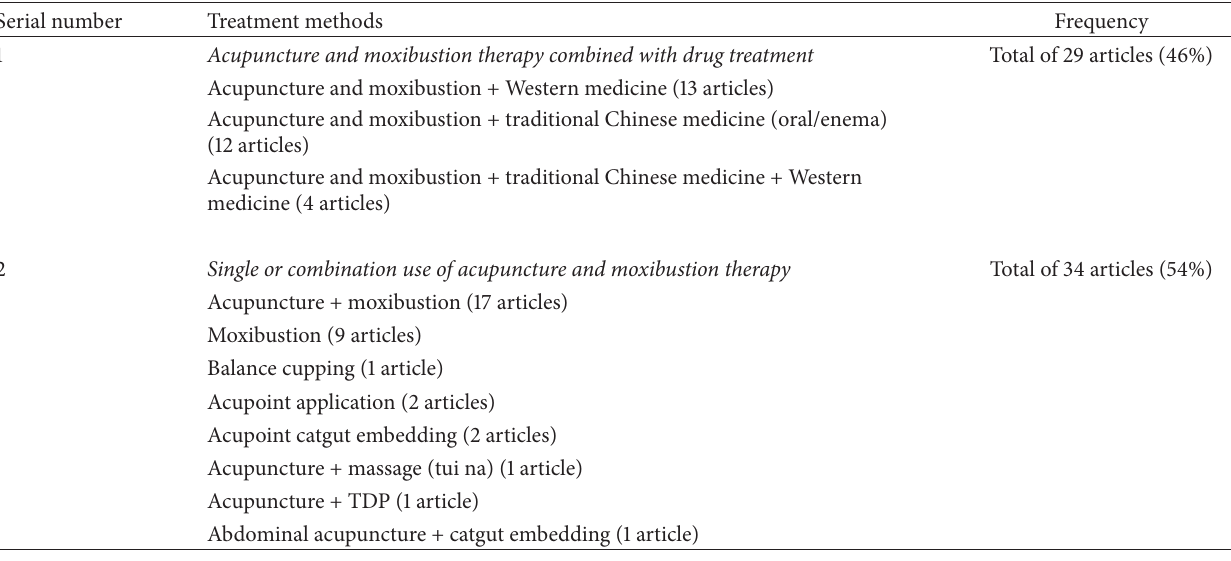
Table 2: Statistical analysis of classification of intervention measures in experimental groups.